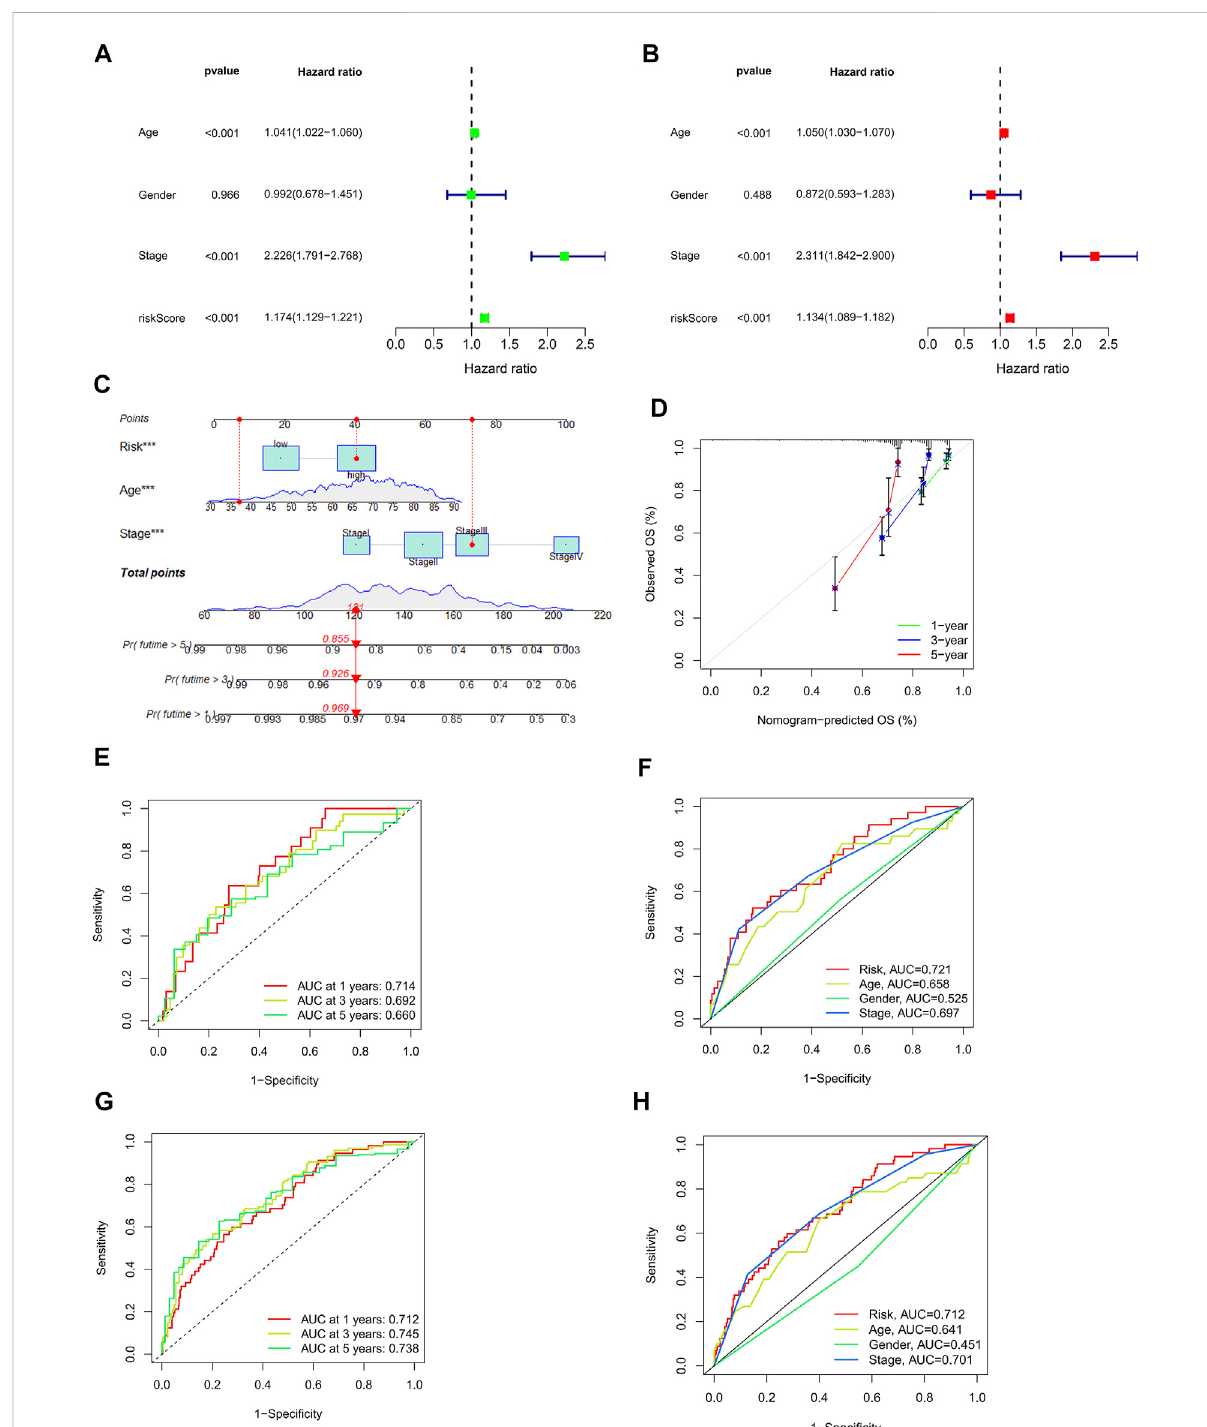
FIGURE 5 Assessment of the risk model and a detailed analysis of the nomogram. (A,B) Analysis of clinical factors and OS risk score using uni- and multi- coxmodels. (C) Anomogramincorporatingtheriskscore,age,andstageofthetumorpredictedthelikelihoodofsurvivalat1,2,and3-yearsintervals. (D) Calibration curves for the 1-, 2-, and 3-years OS. (E – G) The 1-, 2-, and 3-years ROC curves for the train, the test, and the entire set, respectively. (H) The 3-years ROC curves of risk score, and clinical